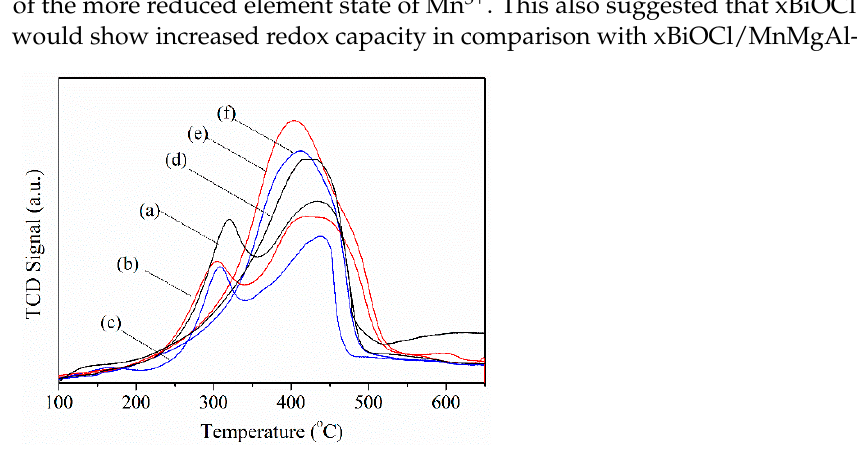
Figure 4. H 2 -TPR images of (a) 0.005BiOCl/MnMgAlO, (b) 0.01BiOCl/MnMgAlO,